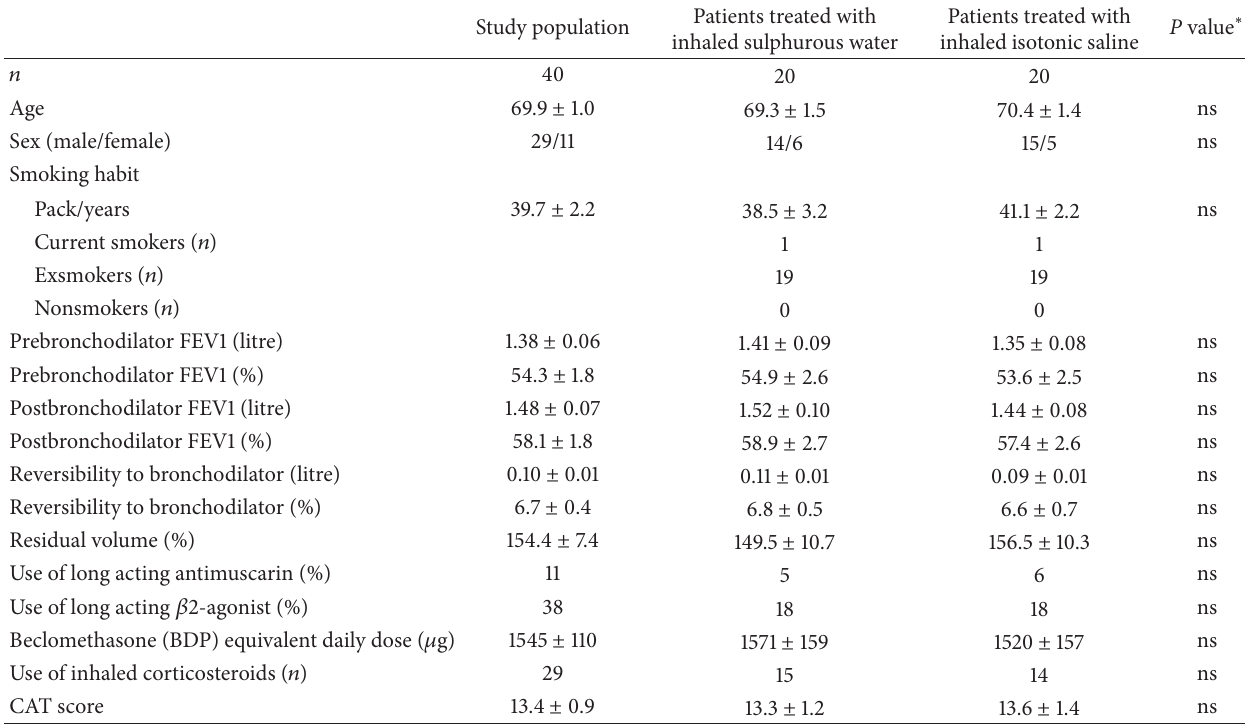
Table 2: Characteristics of the study population at the baseline.